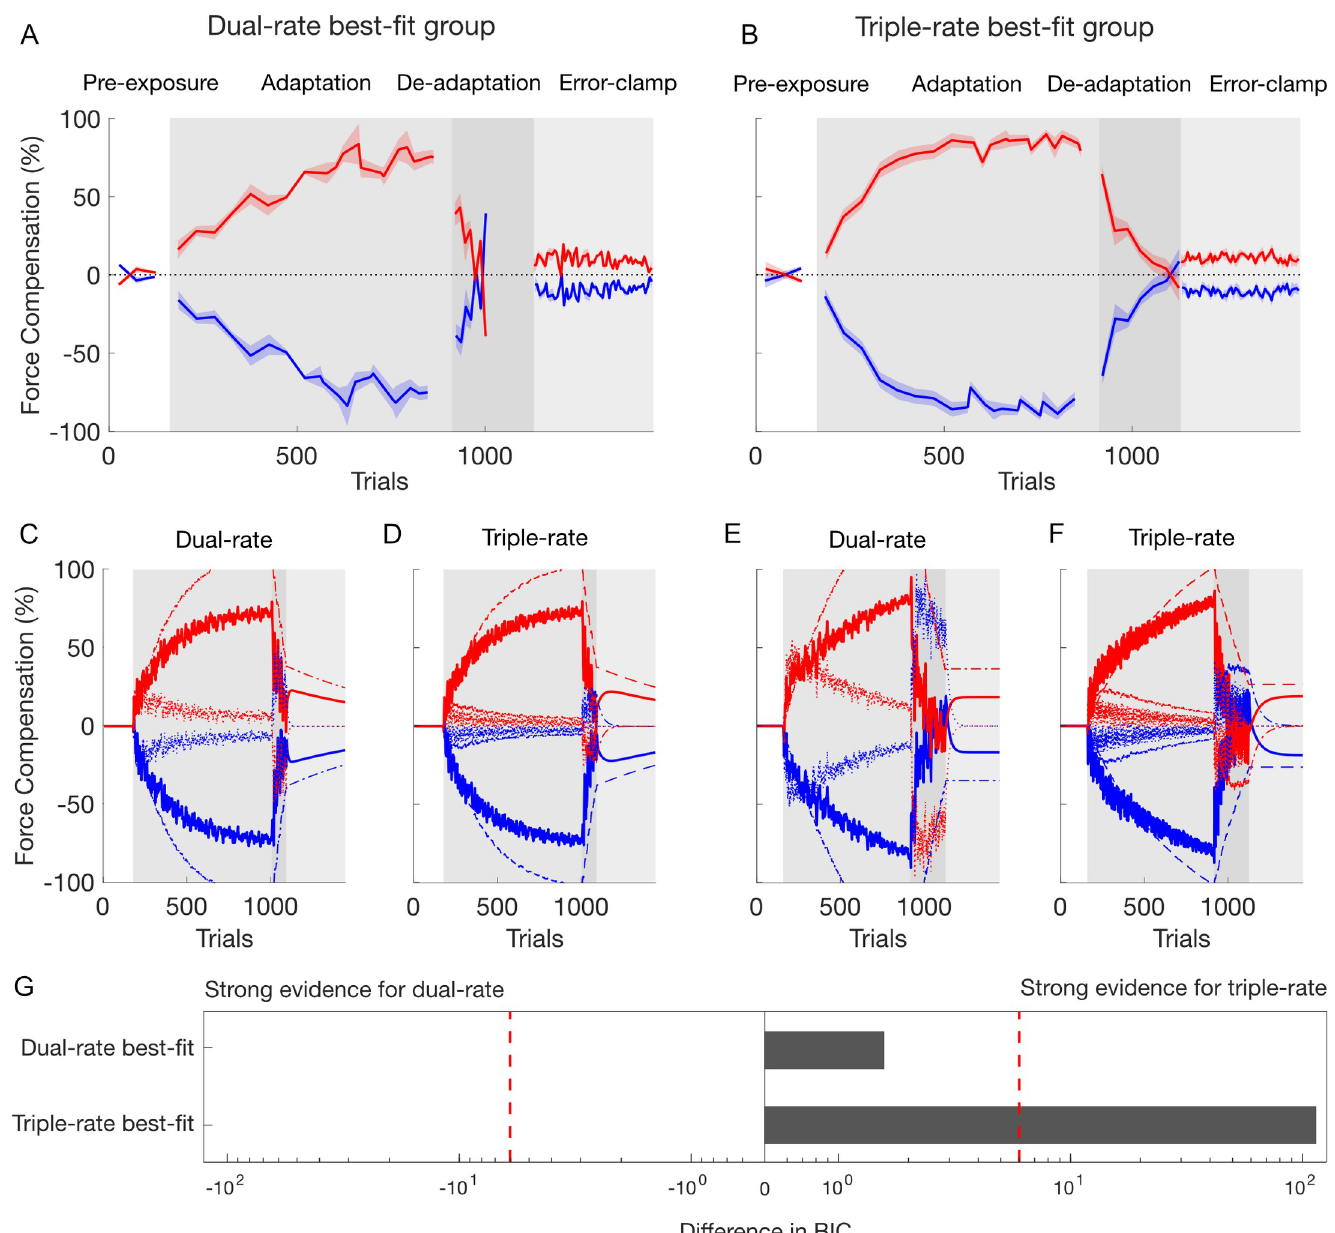
Fig 5. Comparison between the 3 participants best-fit by the dual-rate model (left side) and the 7 participants best-fit by the triple-rate model (right side). A. Mean of force compensation for the dual-rate best-fit group of participants. B. Force compensation for the triple-rate best-fit group of participants. C-F. Simulation of the dual and triple-rate models (weighted switch) from the fitted parameters of the dual-rate best-fit group (C and D respectively) and the triple-rate best-fit group (E and F respectively). The models were fit to the mean participant data rather than individual participants. Here, the de-adaptation phase contained 80 (C, D) and 208 (E, F) trials corresponding to the average trials number for the dual-rate best-fit and triple-rate best-fit groups respectively. The total output for each contextual cue thick red and blue lines) is composed of the summation of each process: fast (solid lines), slow (dotted lines) and ultraslow (dashed) process. G. BIC differences between dual-rate and triple-rate models for both groups. The red dashed line shows a BIC difference of 6 from the best-fit model.